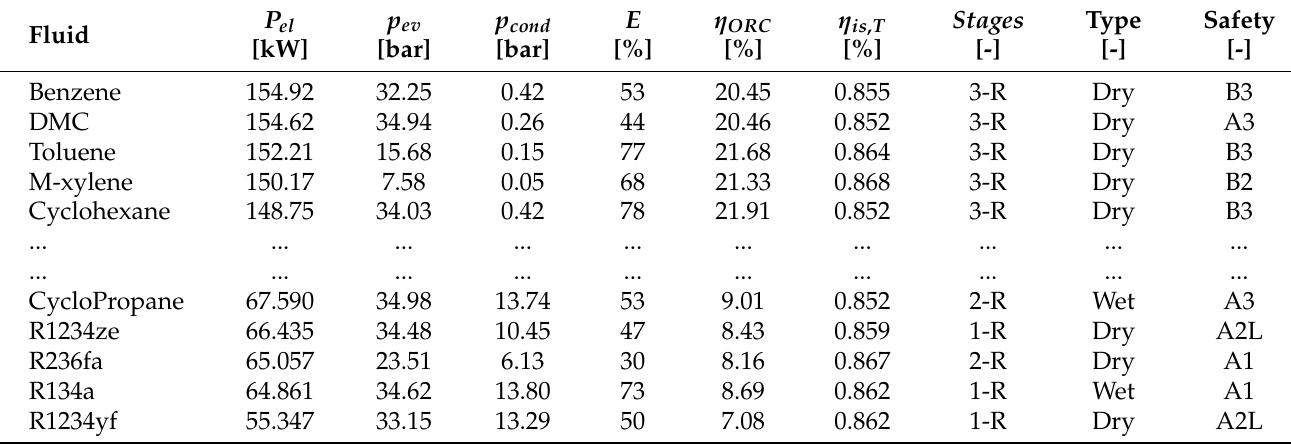
Table 8. The 5 best and worst fluids and in the case of an ORC adopting an oil thermal